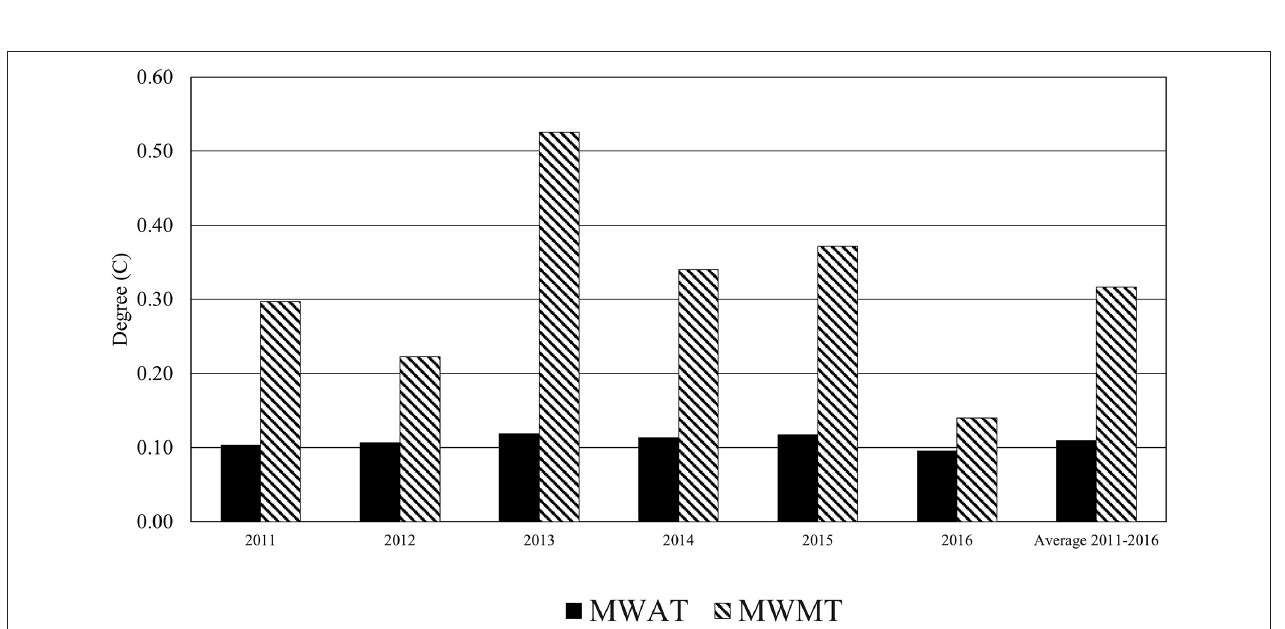
FIGURE 10 | Temperature ( ◦ C) differences between MWAT and MWMT values for pre and post harvest